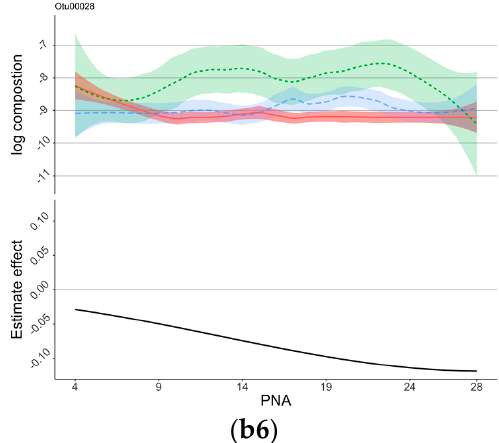
Figure 3. Control sign and OTUs for NHANDLING. ( a ) Control sign and NHANDLING. ( b ) OTUs associated with NHANDLING scores. ( a ) The proportions of the signs of the estimated coefficients of the control variables. Proportions of negative signs were shown as black blocks to the right, and those of positive signs were shown as light gray blocks to the left. Lower NHANDLING scores indicated better development, those variables in black indicated association with lower NHANDLING scores. The red dotted lines show the 90% of bootstrap. ( b1 – b6 ) The estimated time-varying effects of OTU on NSTRESS scores during the NICU stay. The x-axis represents the days after birth (PNA, postnatal age), the y-axis represents the log composition of the OTU abundance (top panel) and the estimated effect (bottom panel). The top panel “log composition” displays the trend of the log-transformed OTU compositions over the first 28 days of NICU stay for infants with different NHANDLING scores, with the infants being separated into three groups based on their NHANDLING score: high NHANDLING score (plotted in red), medium NHANDLING score (plotted in green), and low NHANDLING score (plotted in blue). The bottom panel “Estimate effect” is the estimated time-varying effects of OTUs on NHANDLING scores during the NICU stay.